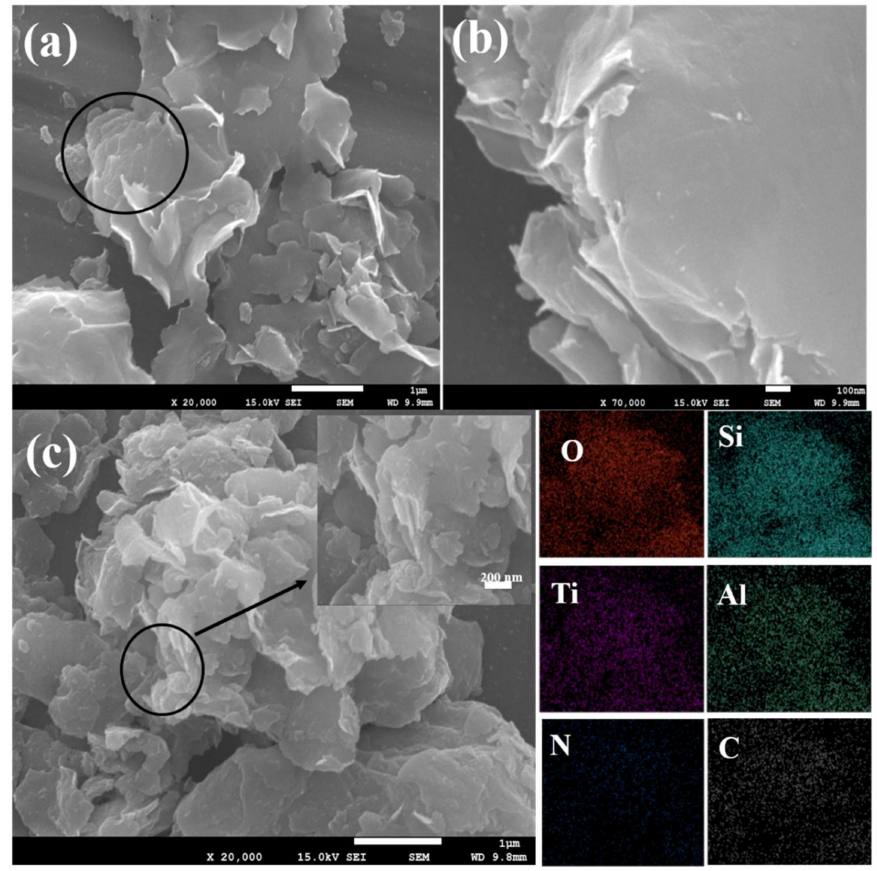
Figure 5. SEM image of Na-Mt ( a ), circle enlarged image ( b ), SEM image of Ti-Mt-APTES ( c ) and EDS results of